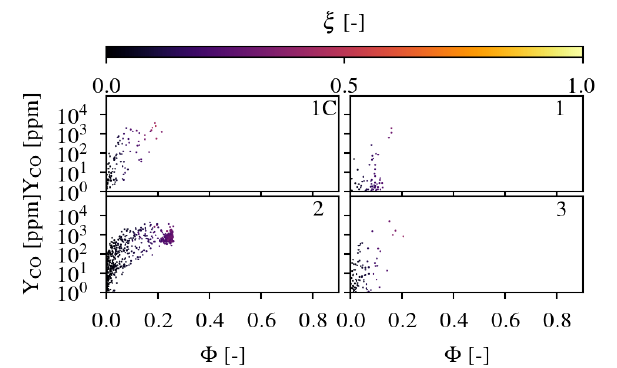
Figure 11. Carbon monoxide mass fractions over equivalence ratio in dependency of the primary air ratio ξ for quenched mixtures in the combustion chamber for the different cases.